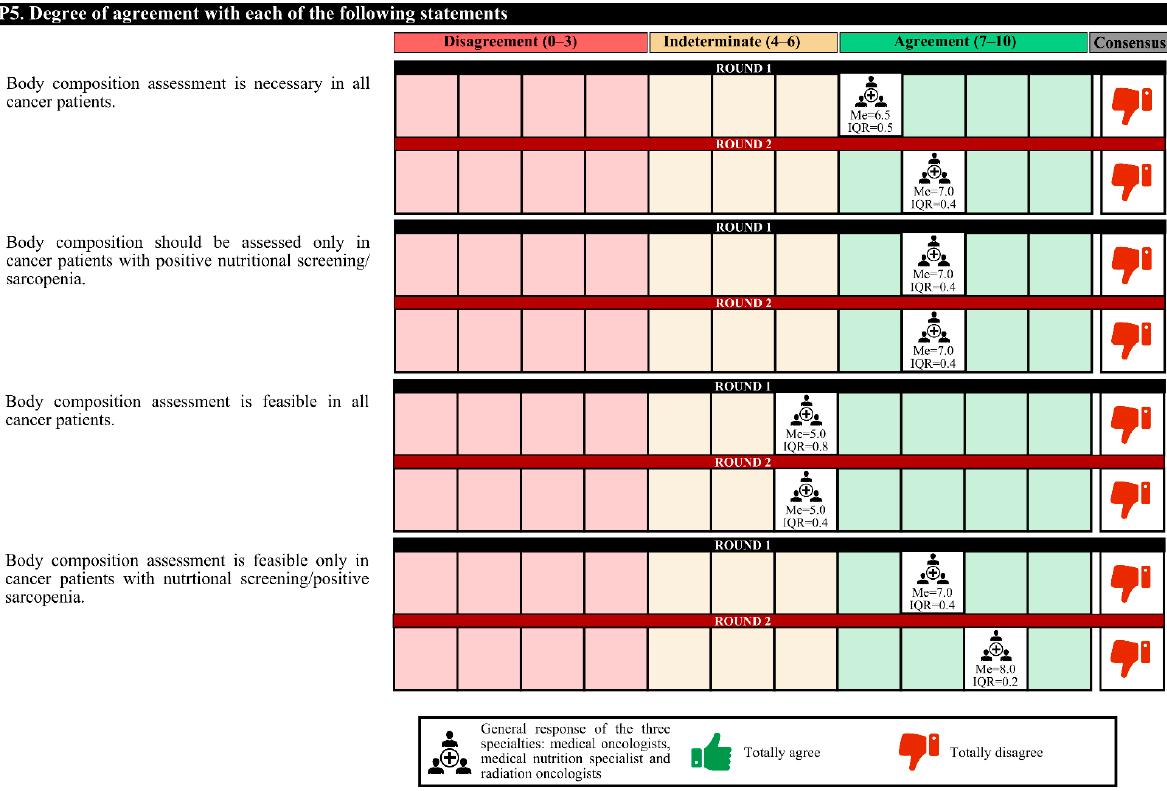
Figure 3. Answers about nutritional screening (II). IQR, interquartile range; Me, median.